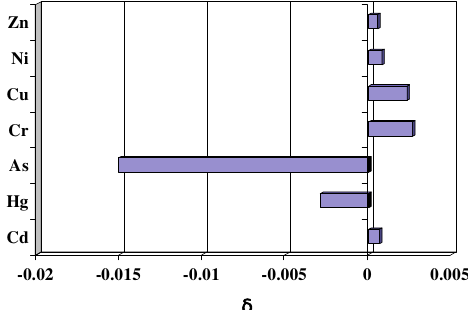
Fig. 20. The relative difference of average energetic index of pollutant emission from motor vehicles in Poland comparing 2015 to